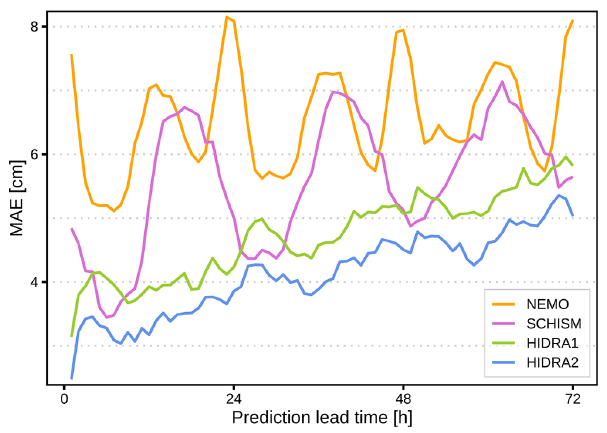
Figure 10. MAE score of the HIDRA, NEMO, and SCHISM mod- els with regard to prediction lead time (between 1 and 72h). Perfor- mance of all the models was evaluated on a 1 June 2019–31 Decem- ber 2020 dataset, which is completely independent of the training